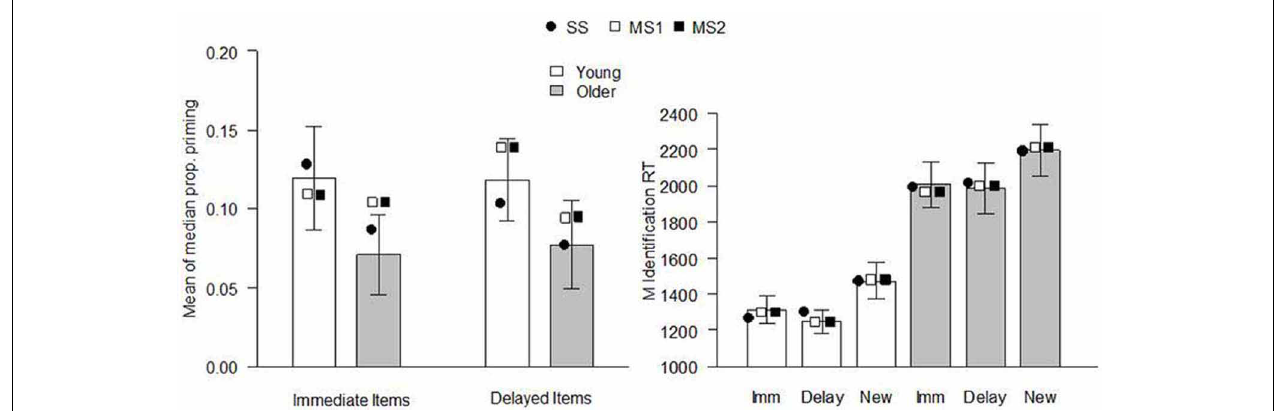
mean expected proportional priming (relative to the expected identification RT for new items, see Table 3 ) from each model when fit to each individual’s data. Right panel: mean identification RTs (ms) of immediate, delayed, and new items. Bars indicate experimental data (error bars indicate SE of the mean), and symbols indicate the mean expected result from each model when fit to each individual’s data. Imm, immediate; Delay, delayed;